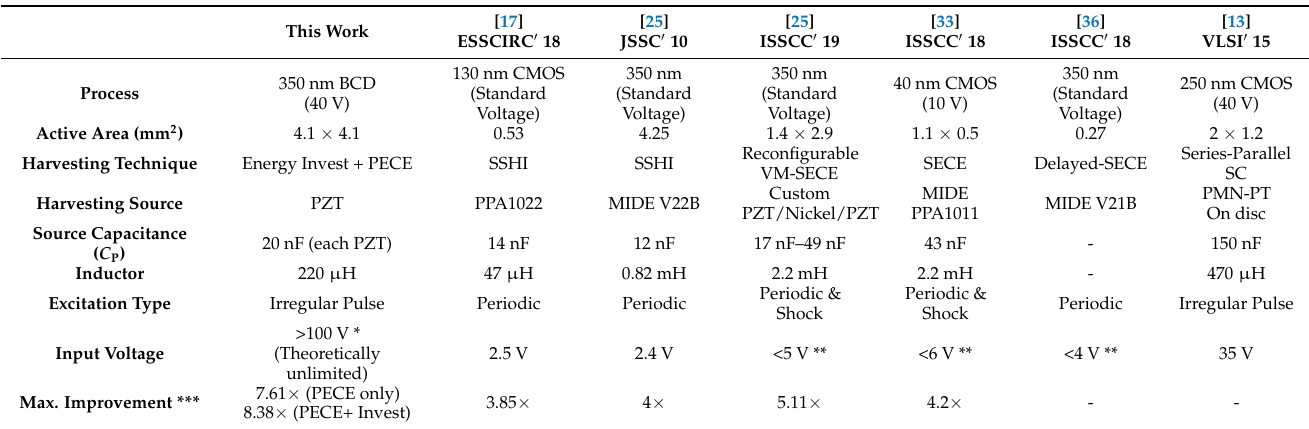
Table 1. Comparison with prior